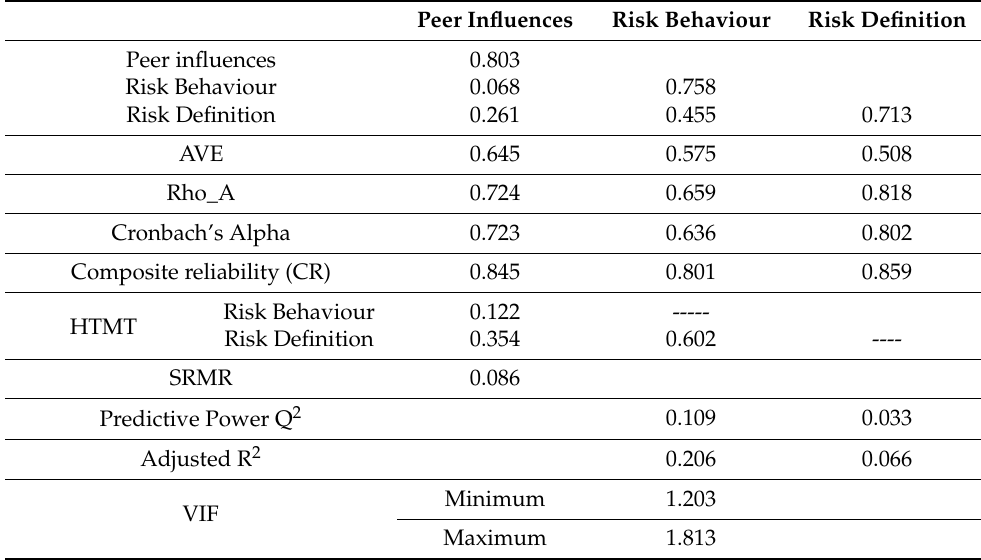
Table 8. Evaluation of Reflective Measurement Models and Structural Models for Model Five.